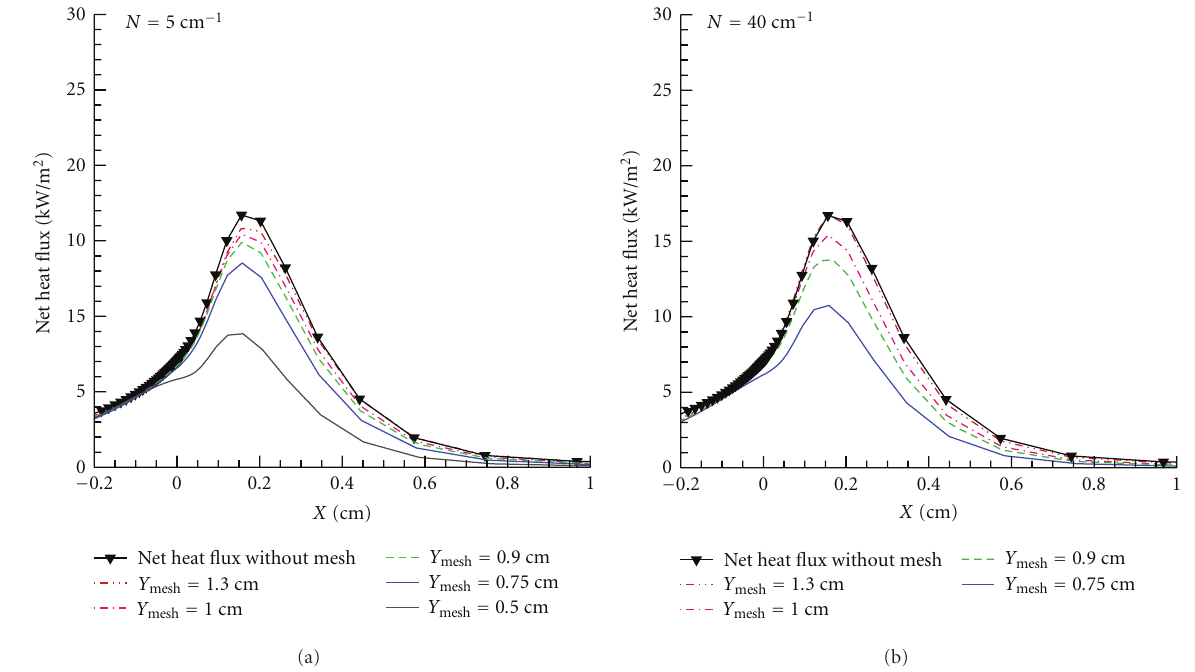
Figure 4: E ff ect of N and Y mesh on net heat flux (a) N = 5cm − 1 (b) N = 40cm − 1 .